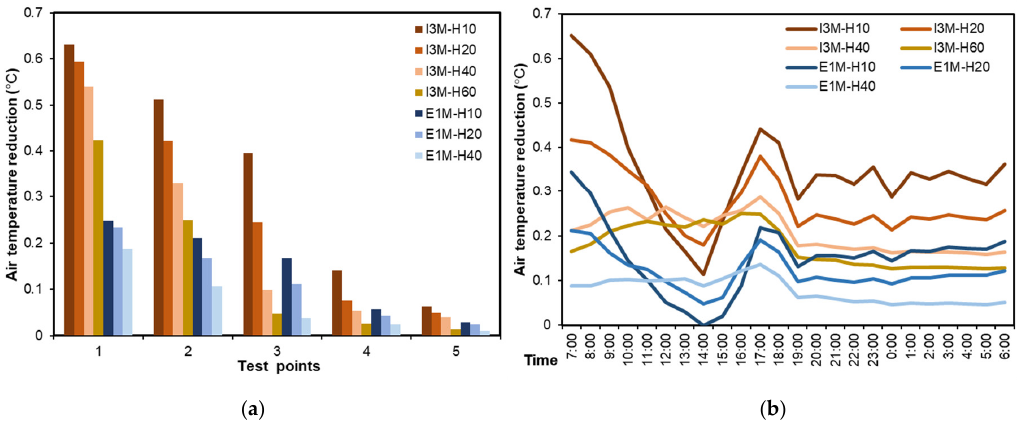
Figure 16. Average air temperature reduction in different building height scenarios. ( a ) Daily average air temperatures at five test points, and ( b ) daily variations of average air temperature of five test points from 07:00 to 06:00 h of the next day.